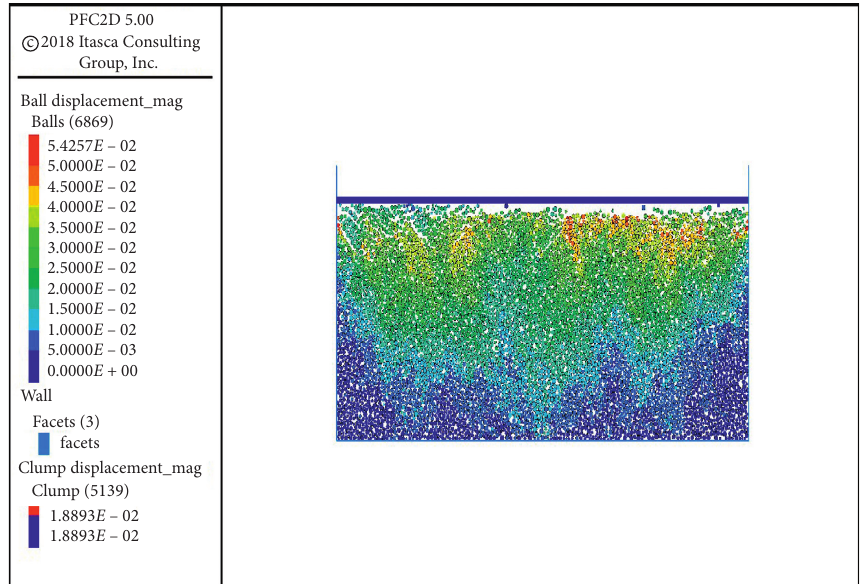
Figure 22: Discrete element particle migration map of 70cm thick reclaimed soil with three